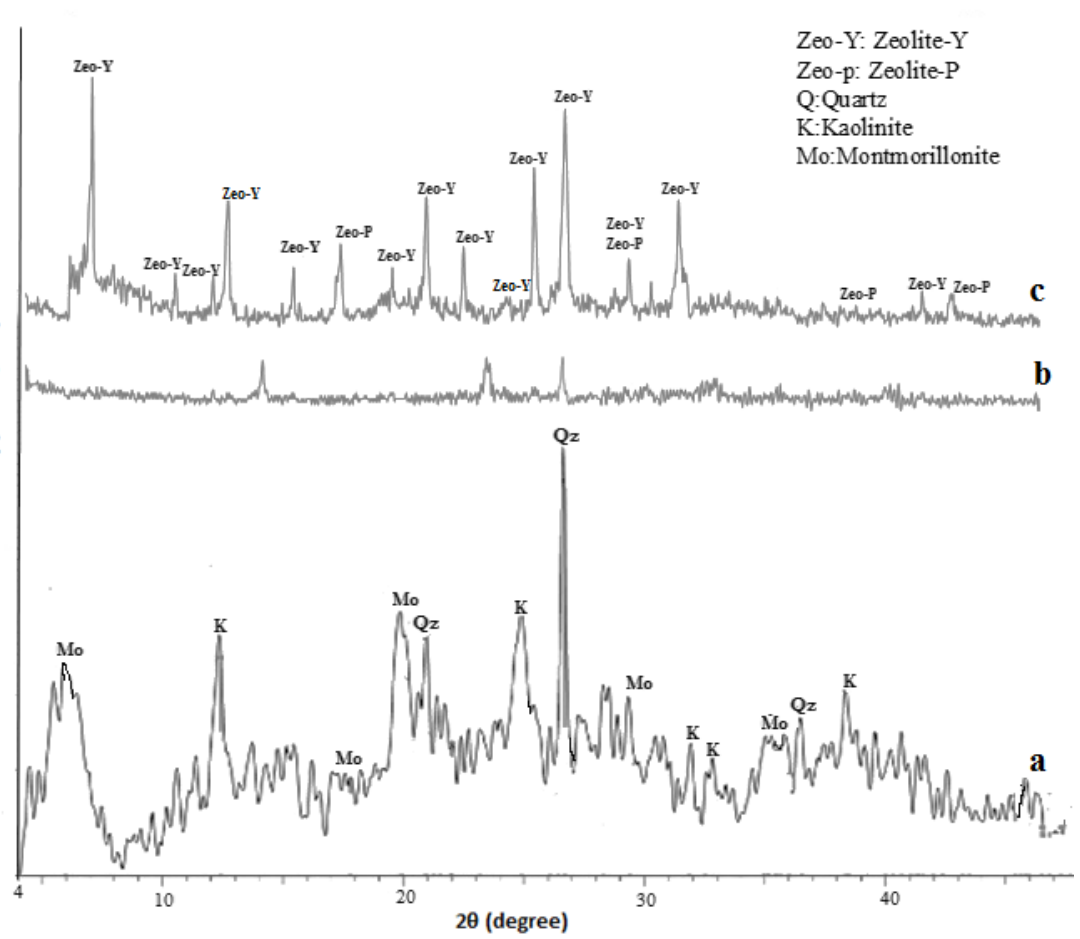
Fig. 3. XRD pattern of raw material (kaolin) (a), metakaolinte (b) and synthetic zeolite –Y (Zeo-Y)